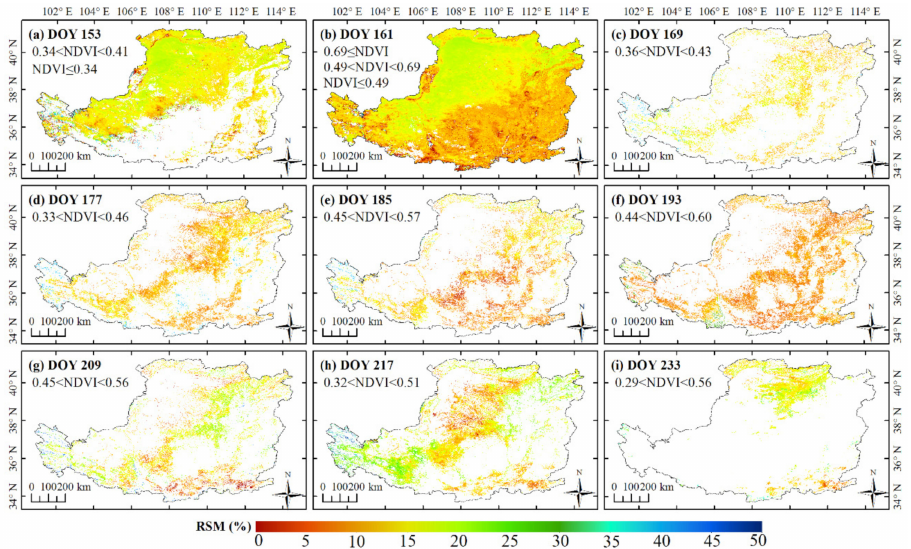
Figure 12. Spatiotemporal patterns of the relative soil moisture in the summer of 2017. ( a ) DOY 153 for 0.34 < NDVI < 0.41 and NDVI ≤ 0.34 using the ATI / TVDI joint model and ATI-based model,